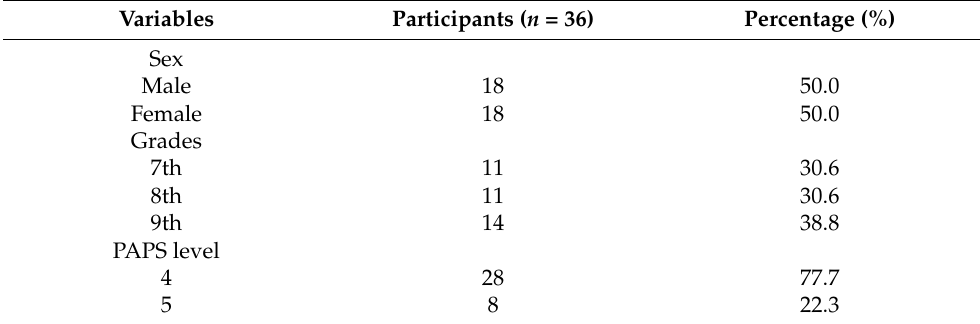
Table 2. Demographic of the study sample ( n = 36).